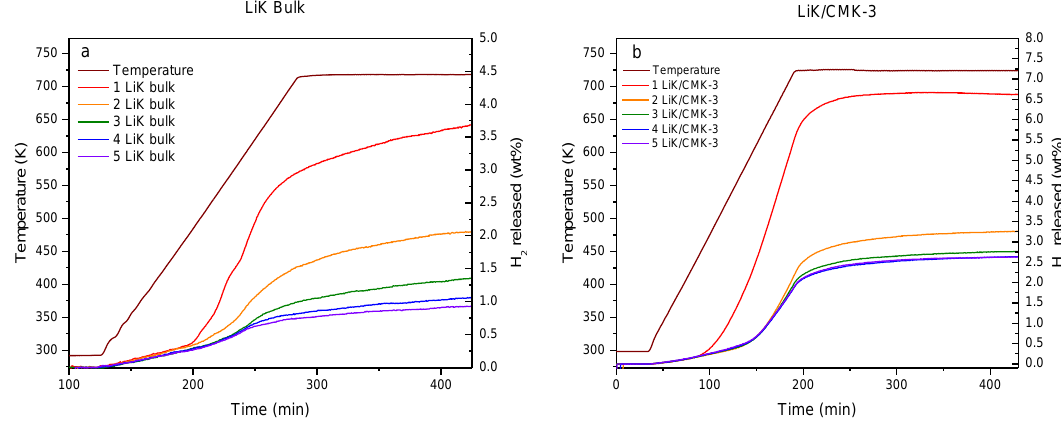
Figure 4. Kinetics of cycling ( a ). Bulk LiK ( b ). LiK/CMK-3 composite.